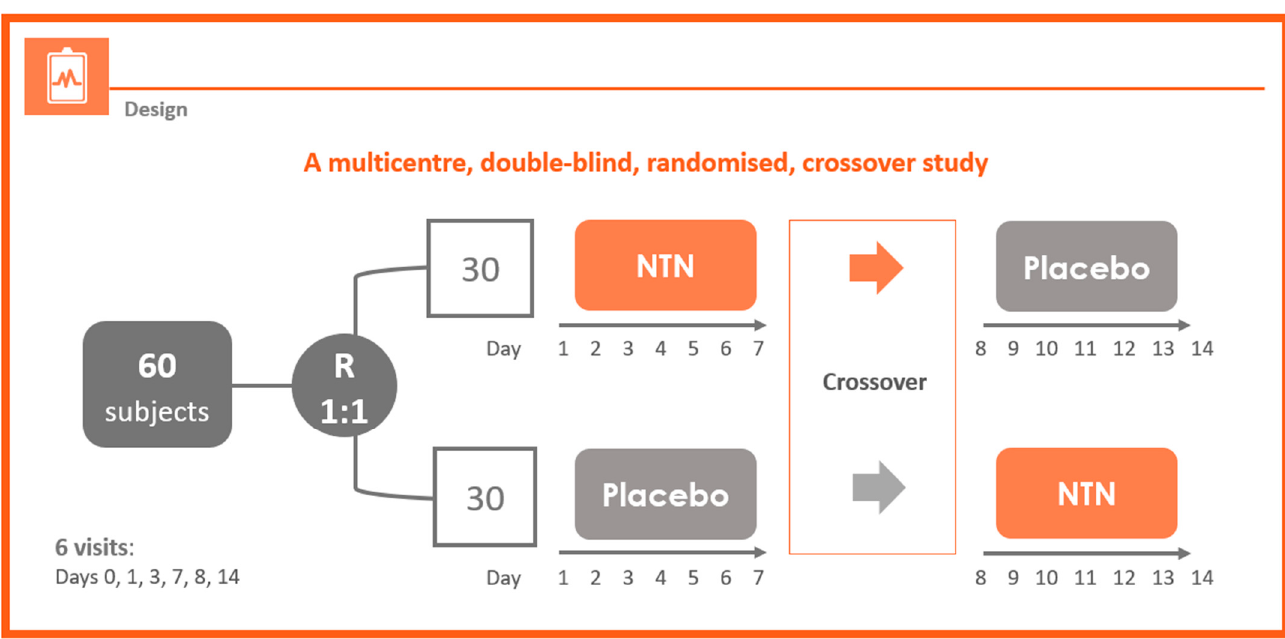
Figure 1. Study design.